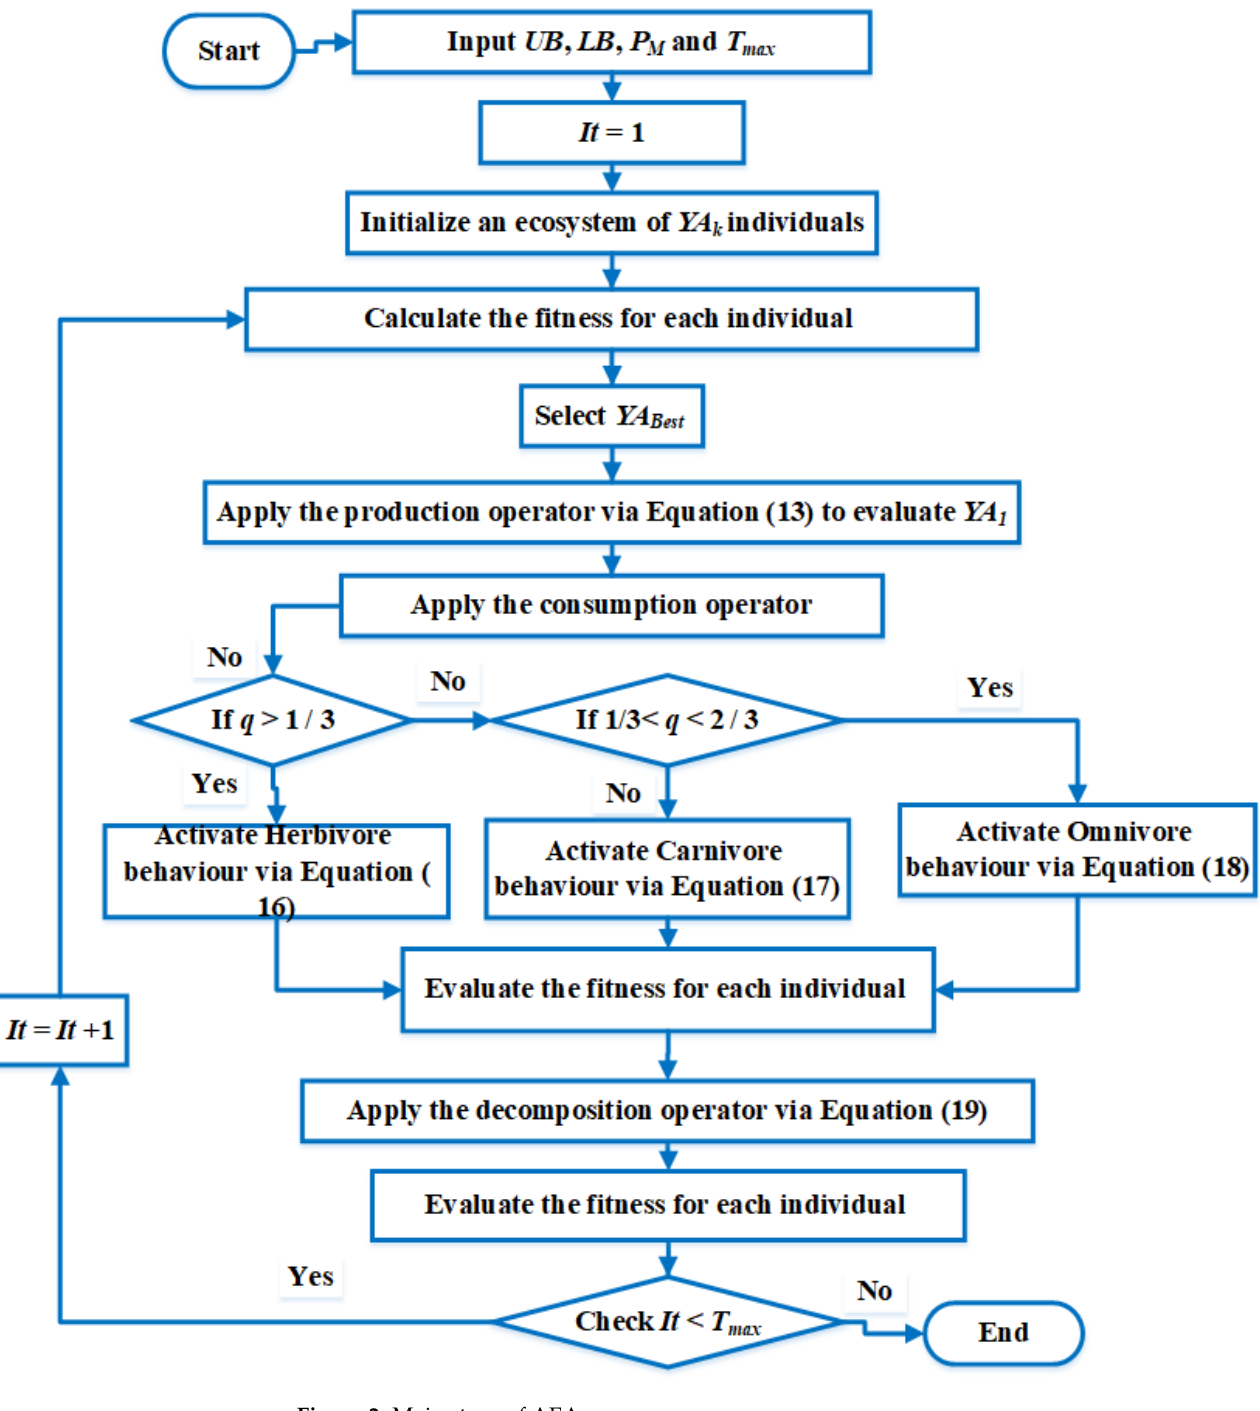
Figure 2. Main steps of AEA.